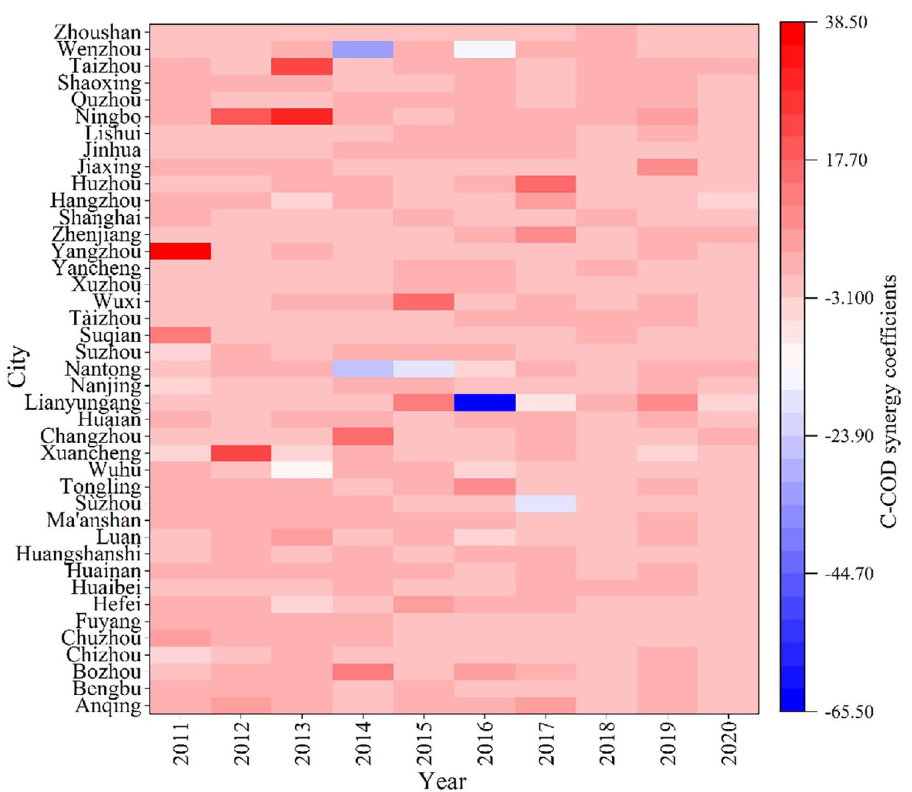
Fig 2. Characteristics of synergistic effect of COD and carbon reduction in agriculture.